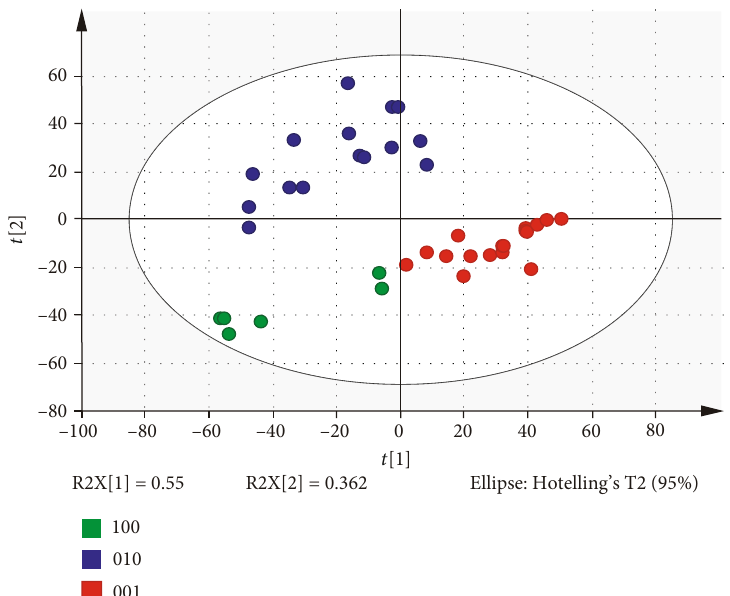
Figure 5: Score plot of PCA. 100: fourth aquifer water; 010: coal-bearing sandstone aquifer water; 001: limestone aquifer water.